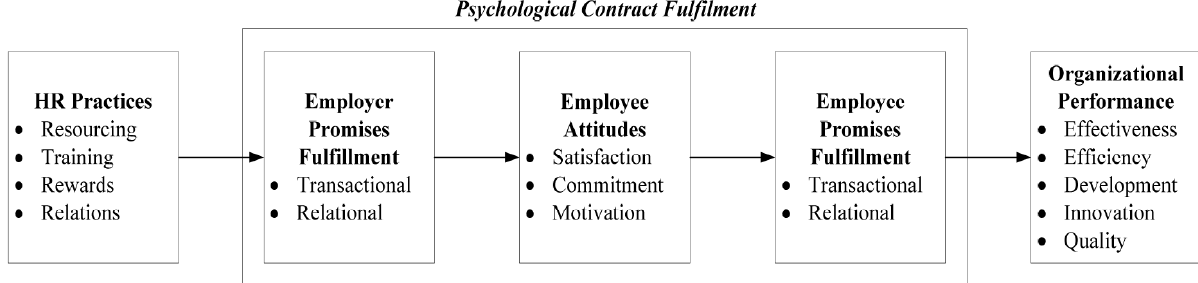
Figure 1. An HR practices – psychological contract – organizational performance linkage